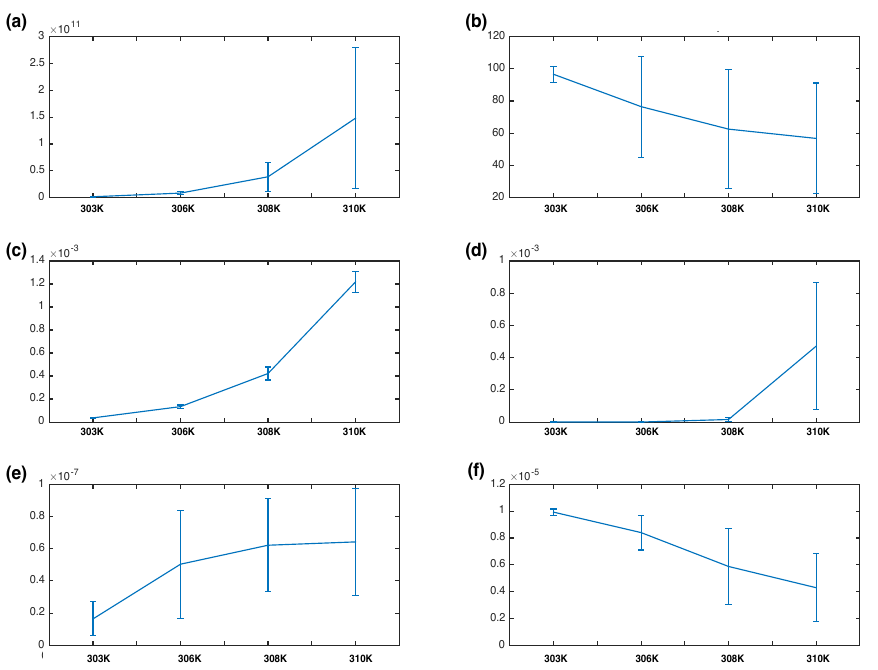
Figure 7. Variation of parameters with changing temperature. The value of each parameters change directionally with increasing temperature. ( a ) The value of k a ; ( b ) the value of k b ; ( c ) the value of k c ; ( d ) the value of k d ; ( e ) the value of r 0 ; ( f ) the value of σ